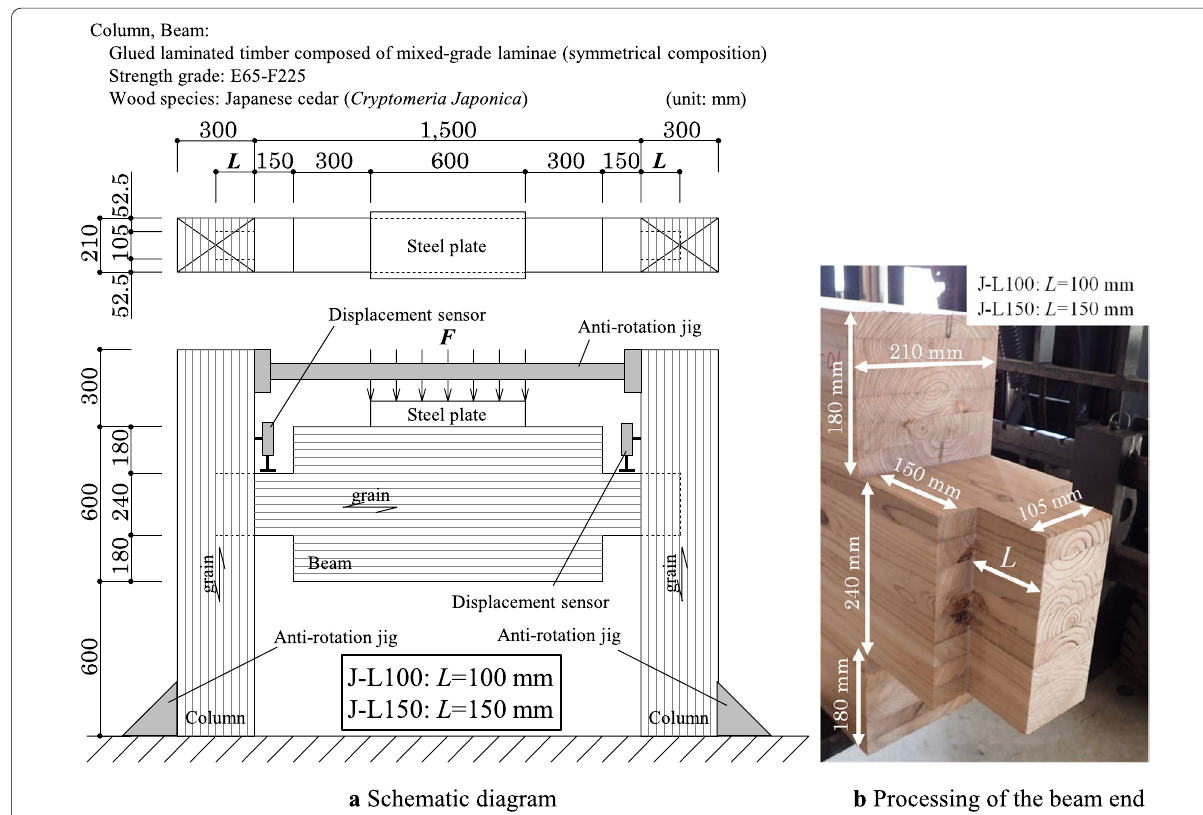
Fig. 3 Shear test of the